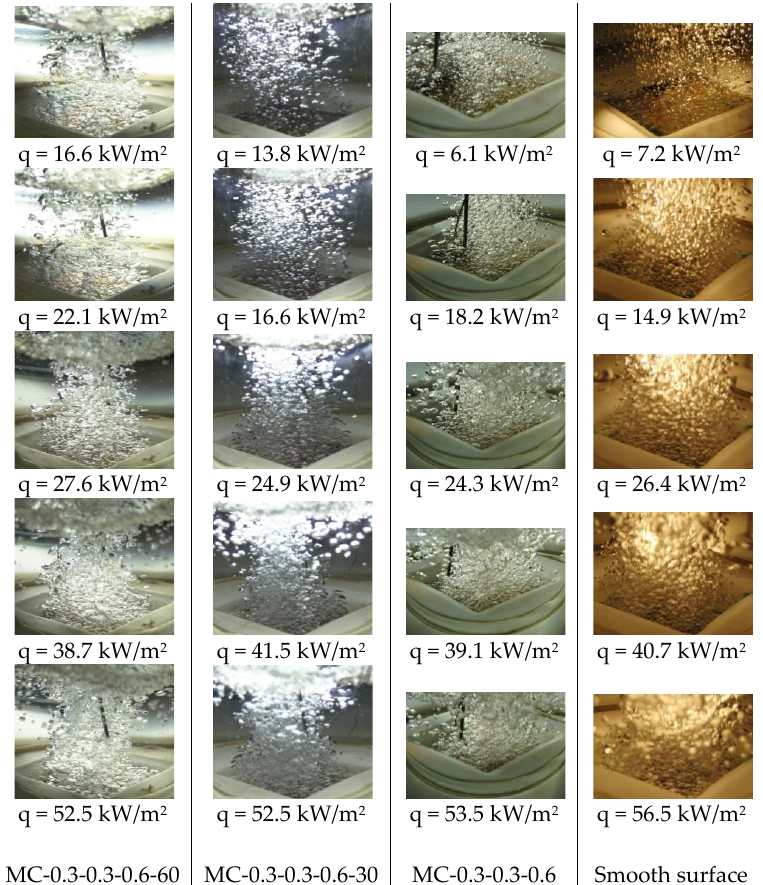
Figure 11. Pool boiling visualization for a NOVEC-649 for smooth plain surface and surfaces with microchannels 0.3 mm wide.